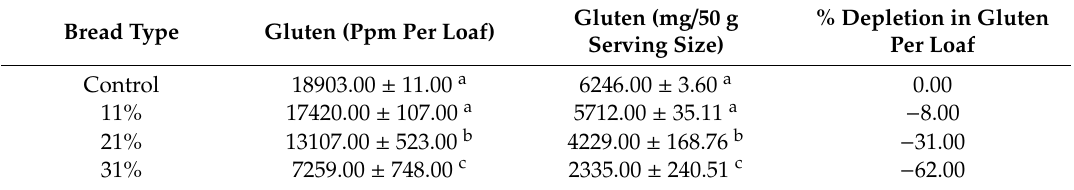
Table 6. Gluten content of control bread, and 11%, 21% and 31% of BBH fortified breads. Bread